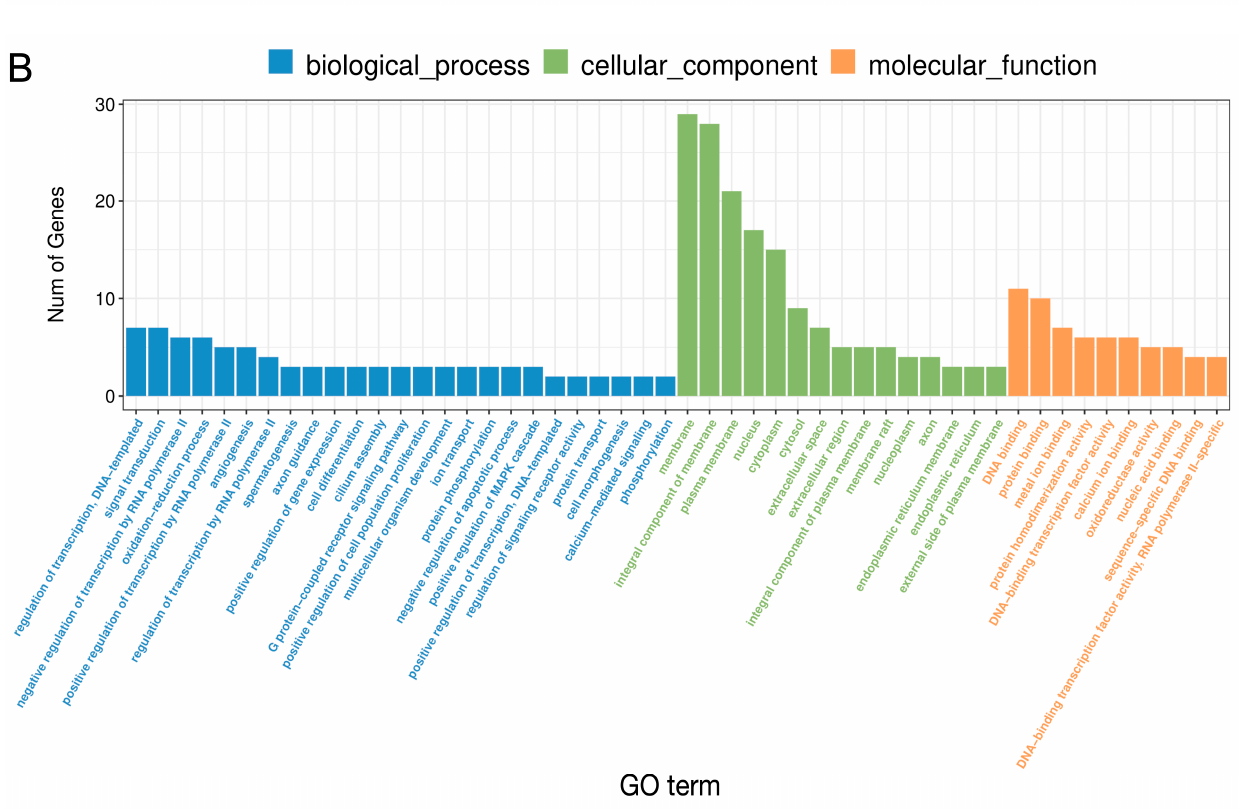
Figure 4. HierarchGO analysis of the differentially expressed genes after the treatment of the corpus luteum with LPS ( A ) or GW0724 at a concentration of 1 µ mol/L ( B ) in the mid-luteal phase of the estrous cycle. The x -axis indicates the terms of biological processes, while the y -axis indicates the number of significant enriched genes ( p <